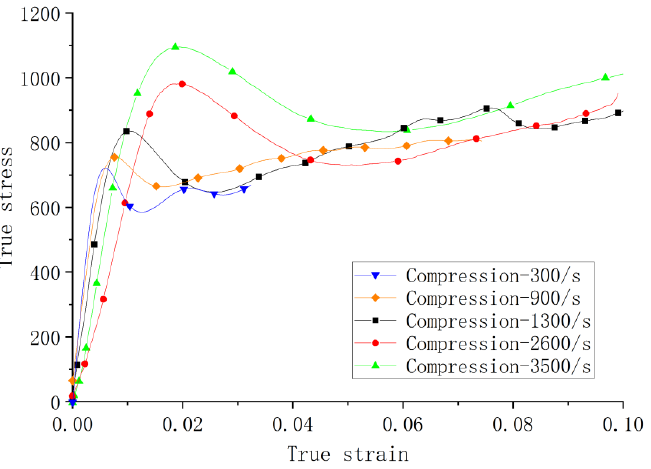
Figure 10. Stress–strain curves of compression tests at ambient